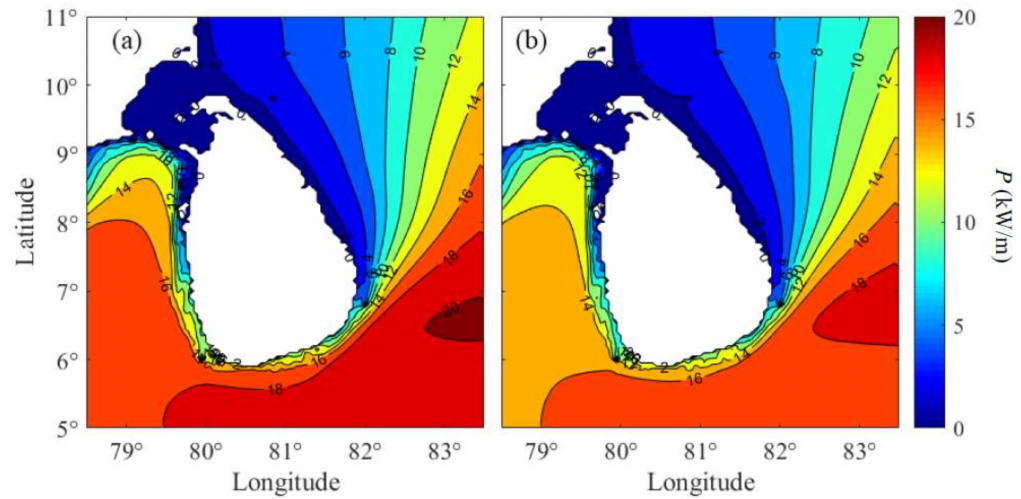
Figure6. Thedistributionof“present”and“future”averagewavepoweraroundSriLanka. ( a )averaged over the “present” 25-year simulation period between 1979 and 2003; and ( b ) averaged over the “future” 25-year simulation period between 2075 and